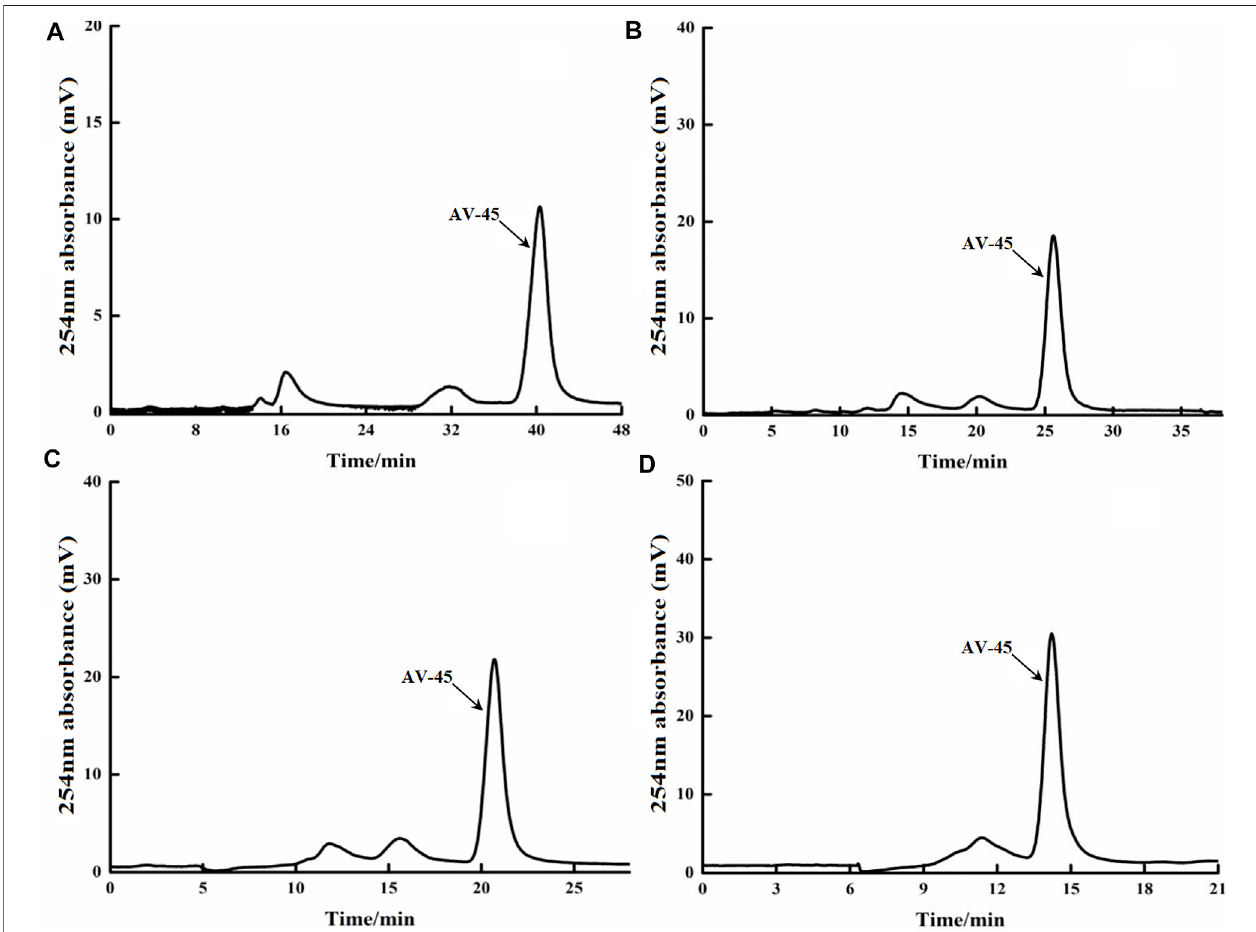
FIGURE 2 | Retention times of AV-45 in preparation HPLC column with different mobile phase ratios. The arrow points to the AV-45 standard peak.